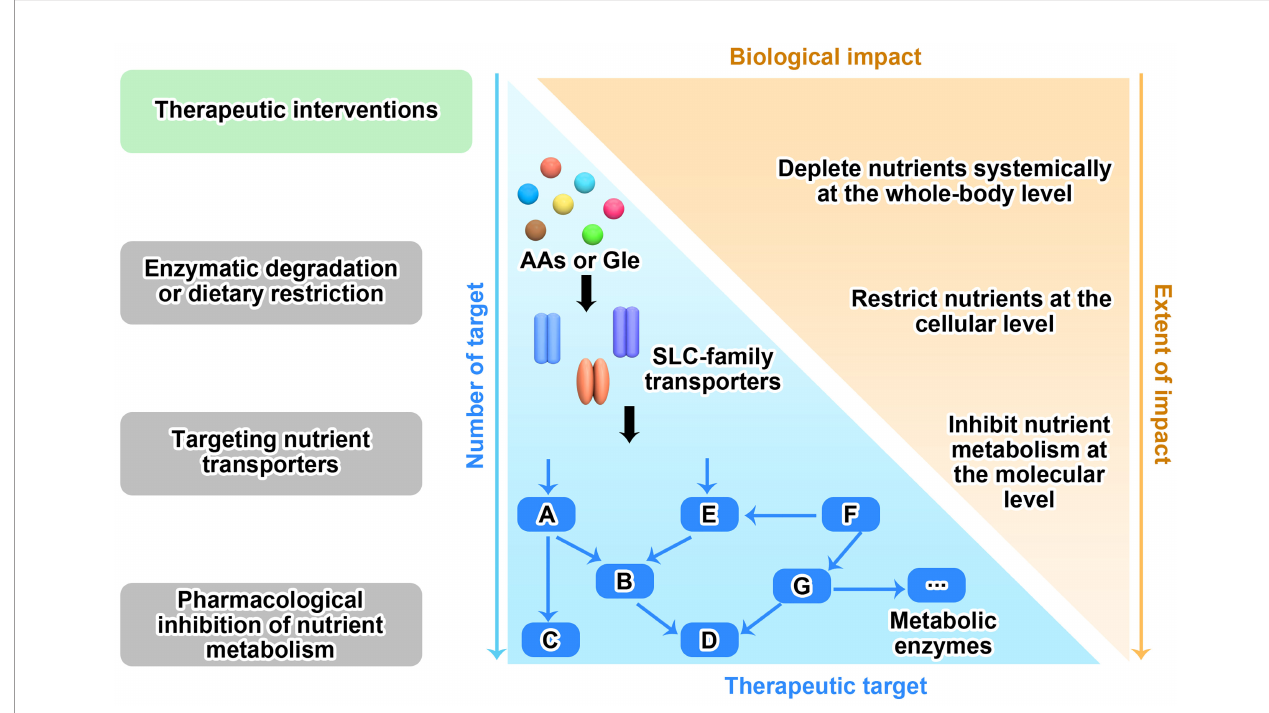
FIGURE 3 | Therapeutic strategies for targeting nutrient dependency. Based on the nutrient availability in surrounding environment, nutrient transport on cell membrane and nutrient metabolism within cell, three therapeutic interventions that targeting nutrient dependency are wildly explored in the fi elds. Like the two sides of a coin, there are pros and cons for each strategy as well. The more therapeutic targets that clearly identi fi ed in the metabolic network, the more chance we are able to translate this strategy into clinical application. However, blocking any one of these targets may only have moderate biological functions in vivo , since each target has very limited functions compared to the whole metabolic